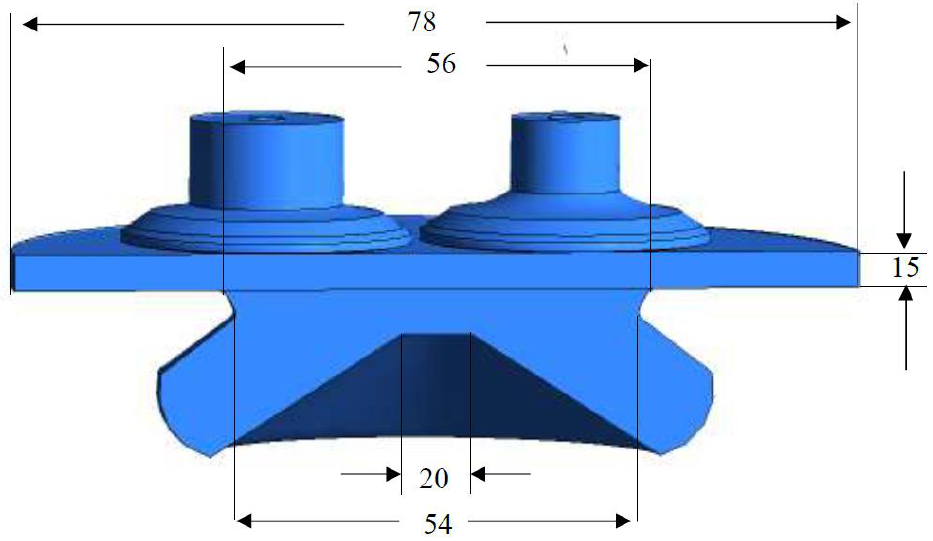
Figure 1. The SCC piston–bowl design (all unit in mm).